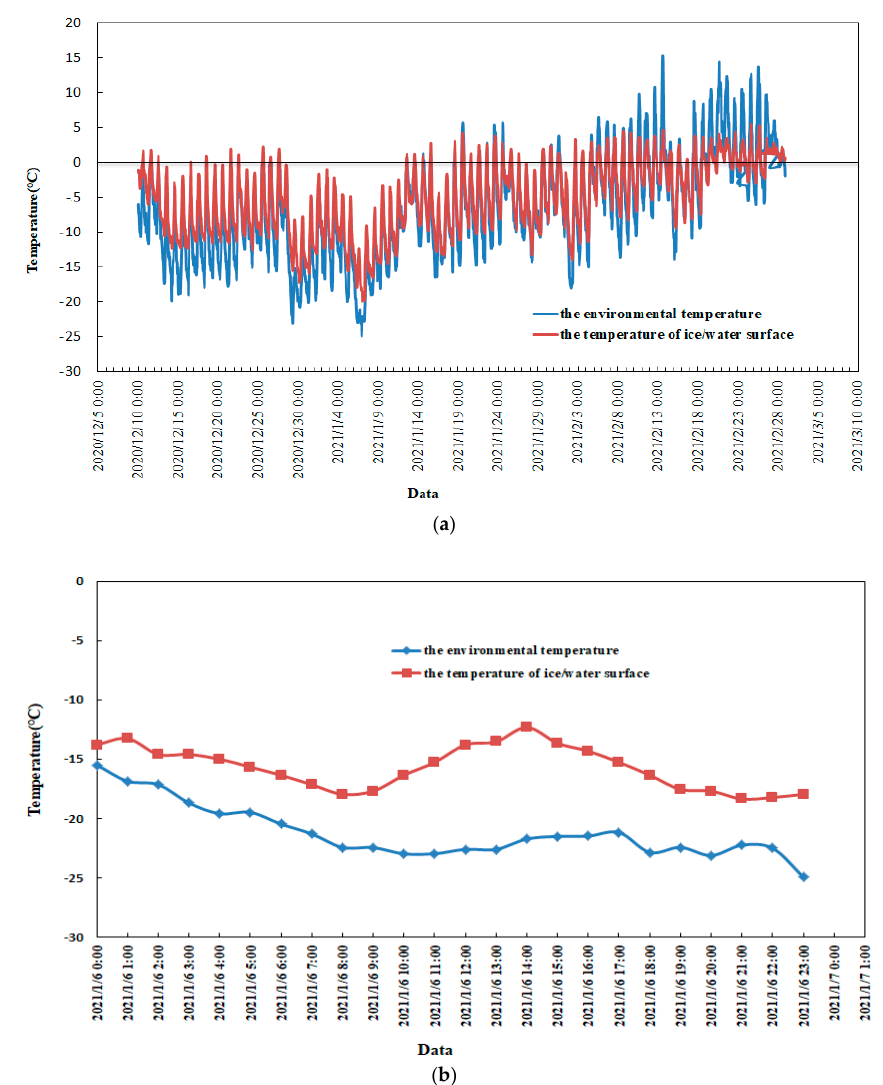
Figure 5. Temperature change process of the Shisifenzi reach. ( a ) Temperature change process of the Shisifenzi reach in 2021–2021 ice period; ( b ) temperature change process of the Shisifenzi reach on 6 January 2021.